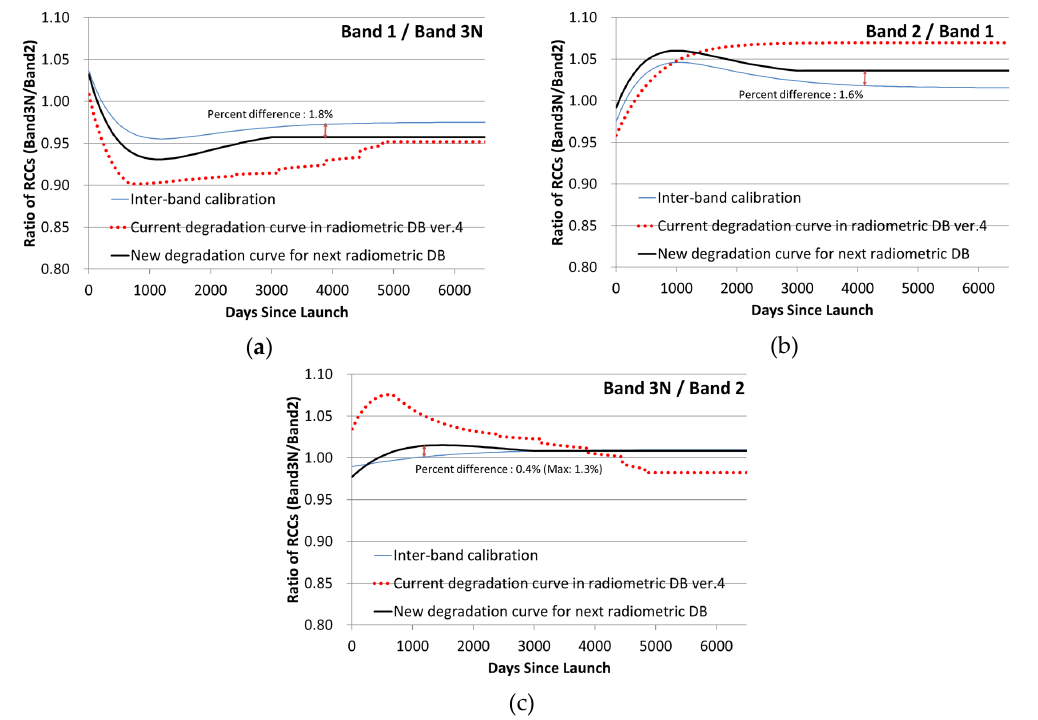
Figure B2. The RCC ratio between bands for each degradation curve for comparison of inter-band consistency. ( a ) Band 1/Band 3N, ( b ) Band 2/Band 1, and ( c ) Band 3N/Band 2.